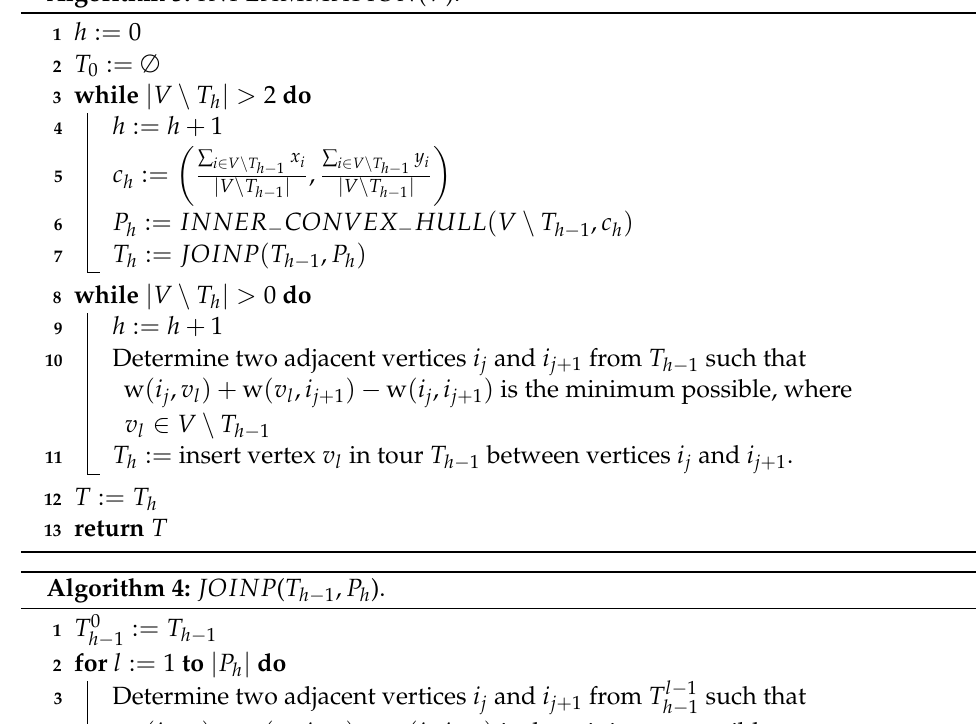
Algorithm 3: INFLAMMATION ( V ).